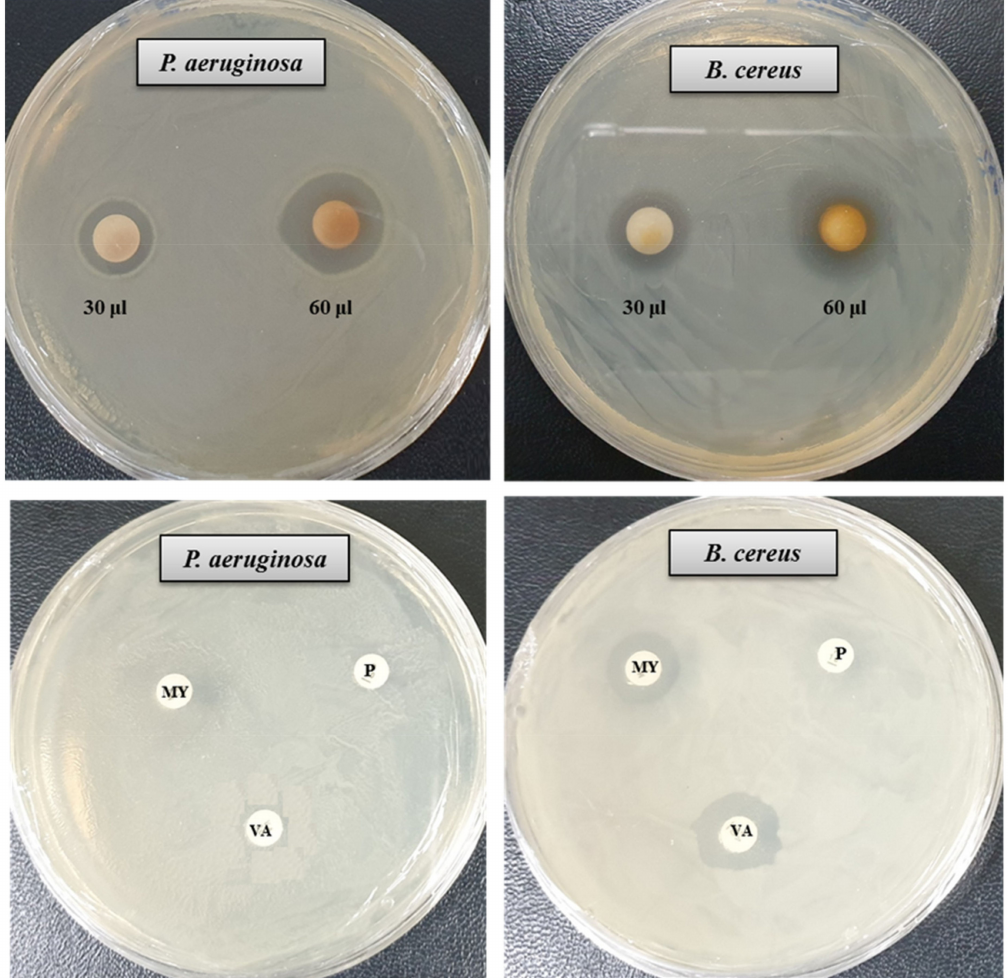
Figure 7. Zones of inhibition of P. nicotinovorans MAHUQ-43-mediated synthesized AgNPs (30 µ L and 60 µ L at 1000 ppm concentrations in water) and commercial antibiotics against P. aeruginosa and B. cereus. Abbreviation: P (penicillin, G 10 µ g/disc), MY (lincomycin, 15 µ g/disc), and VA (vancomycin, 30 µ